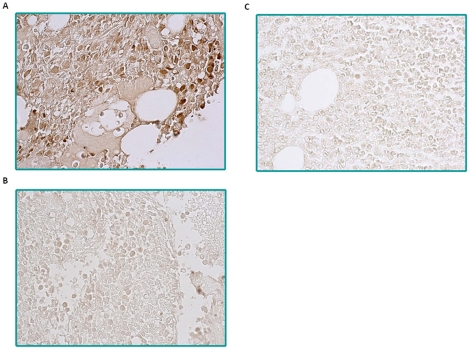
Evaluation of PRL-3 protein expression in bone marrow sections from primary AML patients and normal donors by IHC.(A) A representative image from nine PRL-3 positive AML cases was shown. PRL-3 positive signals were detected in the cytoplasm of myeloid cells. (B) A representative result from ten PRL-3 negative AML cases was shown. (C) A normal bone marrow image from 6 donors was presented. The original magnifications were 63×.